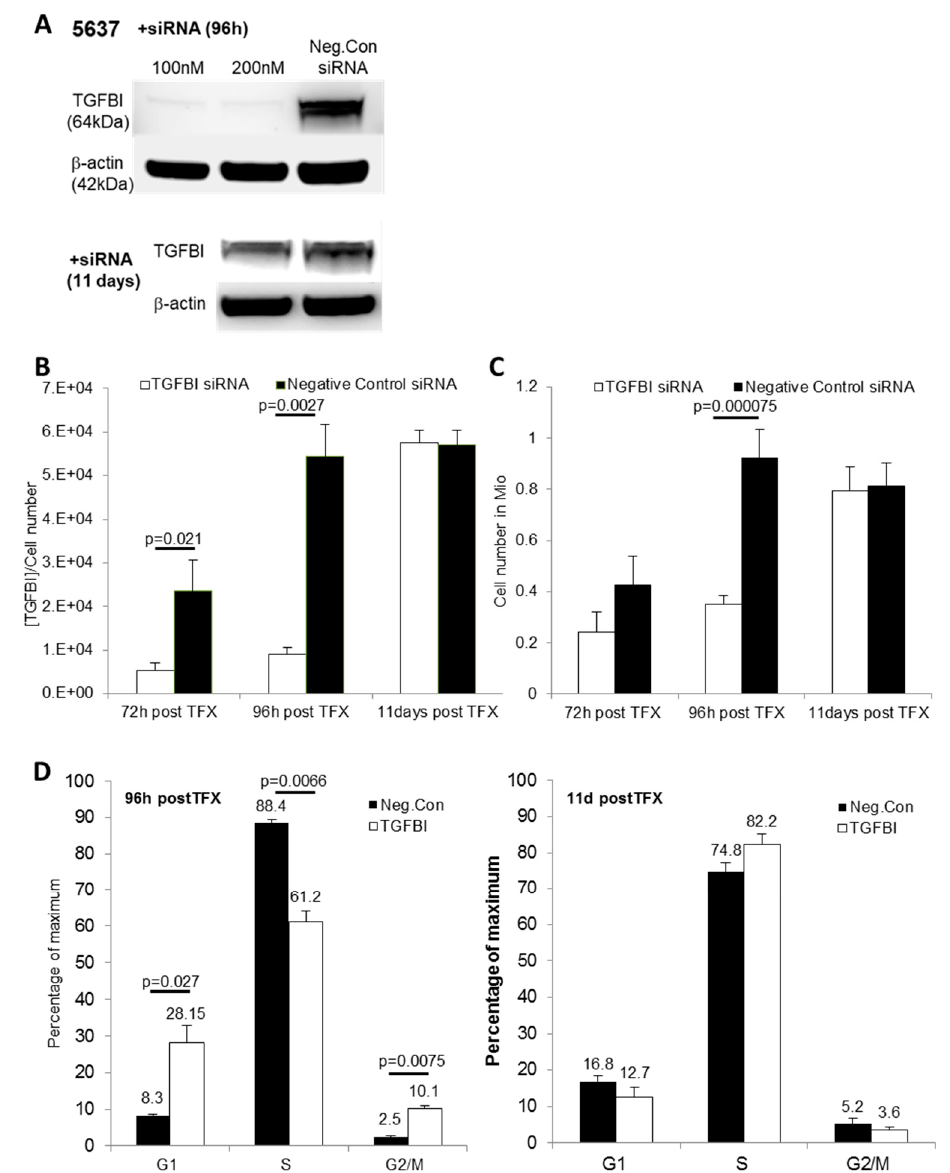
Figure 5. TGFBI siRNA transfected 5637 cells display a lower proliferation rate and an increased G1 cell cycle arrest. Altered protein expression in 5637 cells after successful knockdown with TGFBI siRNA compared to the non-targeting control 96 h and 11 days post-transfection ( A ), caused a significant reduction of TGFBI in the cell supernatant ( B ), which was accompanied by a decreased proliferation compared to the negative control, 72 h and 96 h post-transfection ( C ), and an elevated G1 cell cycle arrest ( D ). The percentage of cells in every cell cycle phase is displayed for each panel. Apoptotic cells were excluded. Error bars are displayed as +SD.